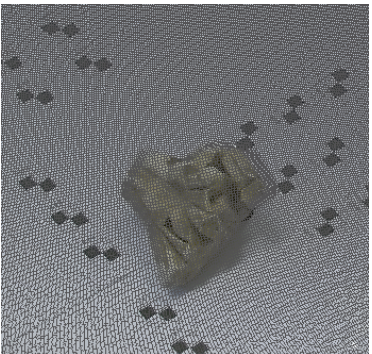
Figure 13. Point cloud of a limestone fragment obtained with Kinect